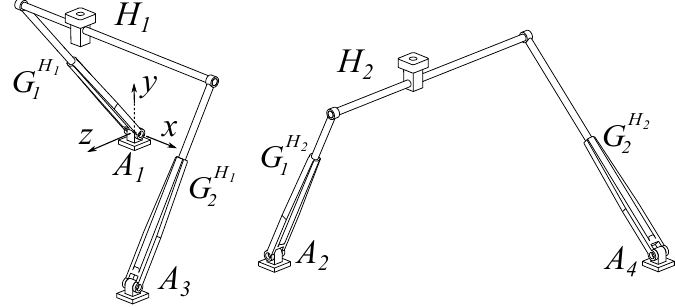
Figure 3. Closed loops of the